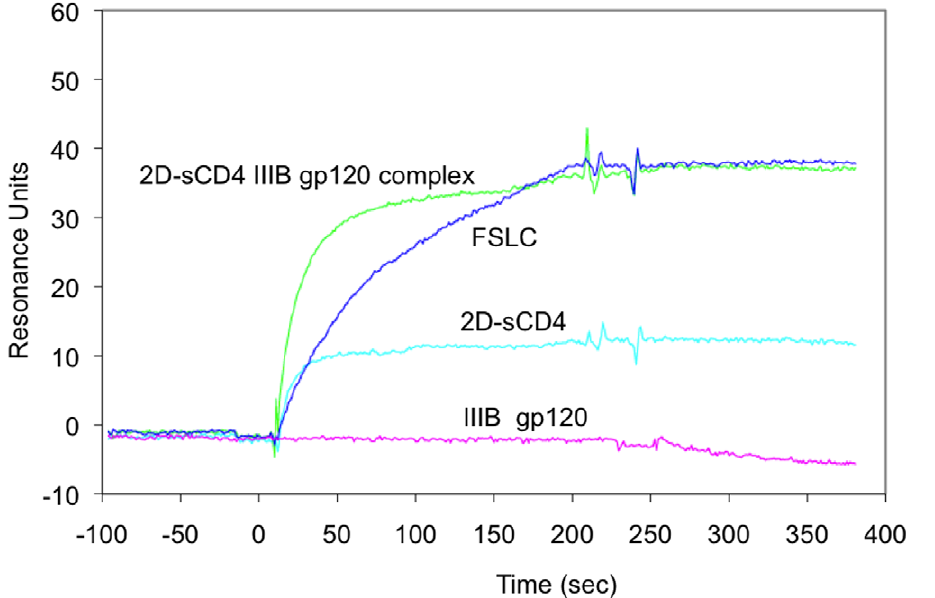
Figure 6. BIACORE H sensogram of interactions between MAb DB81 (bound to the chip) and 2D-CD4 (light blue), gp120 IIIB (violet), CD4-gp120 IIIB complex (green) or the FLSC chiimeric protein (dark blue).